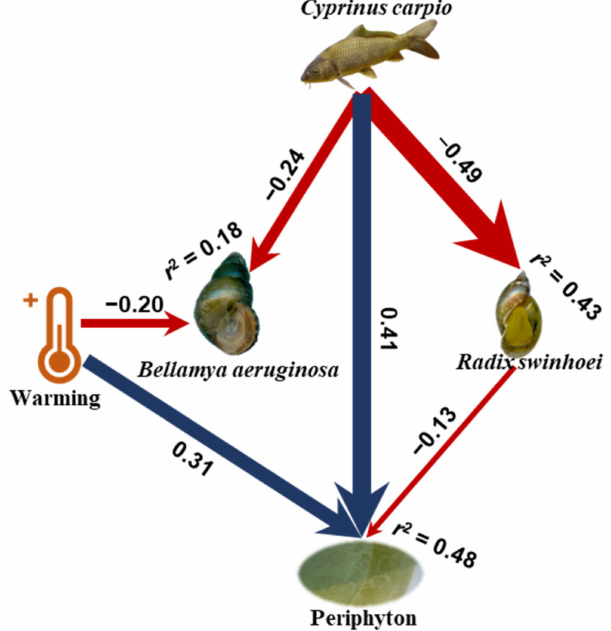
Figure 3. Structural equation model showing the effects of warming with carp ( Cyprinus carpio ) presence on biomass of the two snails ( B. aeruginosa and R. swinhoei ) and periphyton. The goodness- of-fit test of the model is Fisher’s C = 8.615, p = 0.196, df = 6. Exogenous variables are indicated by rounded rectangles, and endogenous variables are represented by ovals. Coefficients of determination ( r 2 ) are shown for all endogenous variables. Numbers adjacent to arrows are standardized path coefficients and indicative of the effect of the relationship. Positive and negative effects among variables are depicted by blue and red arrows, respectively, with arrow thicknesses proportional to the strength of the relationship. All relationships in the model are significant at p <